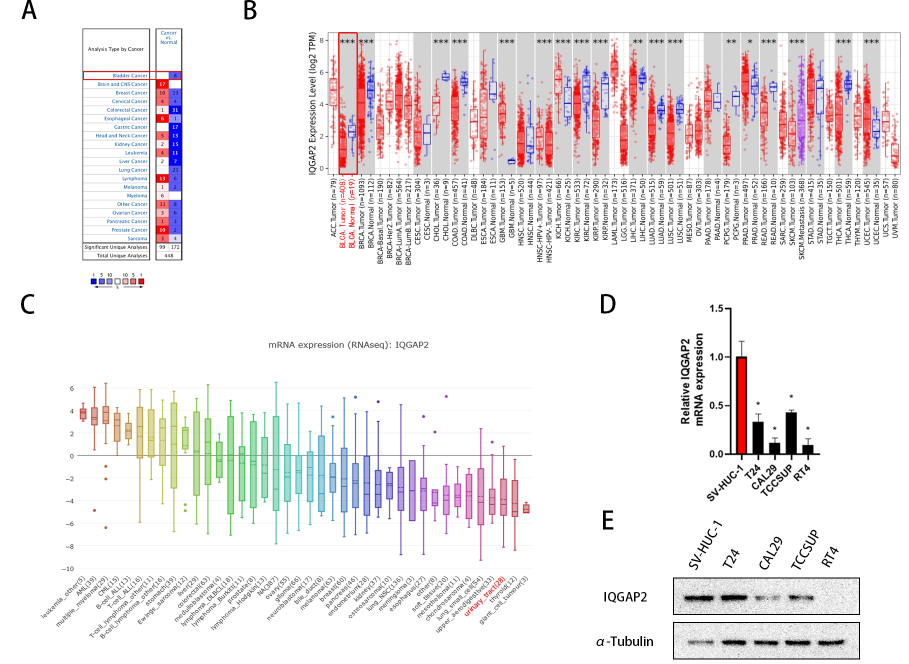
Figure 1. Expressions of IQGAP2 in bladder cancer samples and cell lines. ( A ) The transcription level of IQGAP2 was significantly decreased in normal tissue compared to tumor tissue in different types of cancers, including bladder cancer (Oncomine database). ( B ) The expression levels of IQGAP2 in TCGA tumor tissues and their corresponding normal tissues showed reduced expressions in bladder cancer (Timer). ( C ) The expressions of IQGAP2 in cancer cell lines derived from the urinary tract were low compared to other tumor entities (CCLE) (* p < 0.05). ( D ) The mRNA levels of IQGAP2 in bladder cancer cell lines were decreased compared to urothelial cell line SV-HUC-1. Bar chart presents the meansof replicates ± SEM from three different experiments; * p ≤ 0.05, ** p ≤ 0.01, and *** p ≤ 0.001; Student’s t -test (two-tailed, unpaired) was used for comparison of means. ( E ) The protein levels of IQGAP2 were also decreased in bladder cancer cell lines compared to the urothelial cell line SV-HUC-1 and was lost in